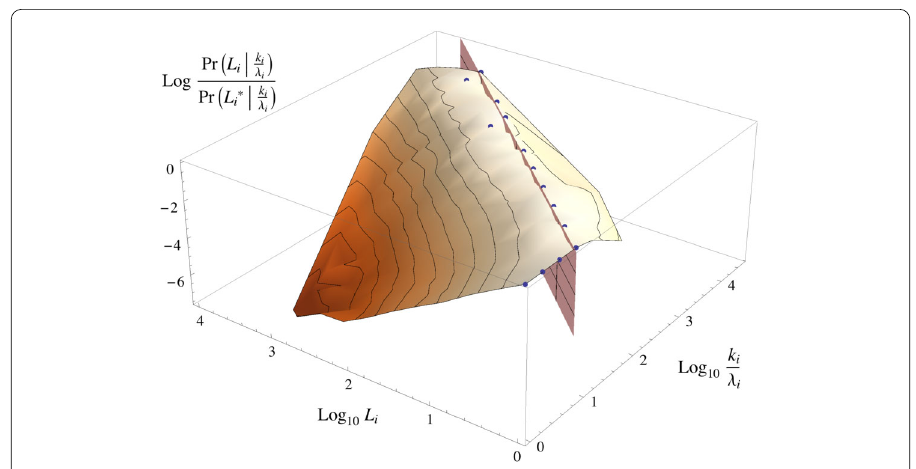
| k S ) with respect to log λ i for Figure 6 Behavior of log 10 [Pr( L i | k i / λ i )/Pr( L ∗ i / λ i )] (surface 10 L i and log 10 k i / i Finland. The data is logarithmically binned as follows: L i belongs to bin b (a non-negative integer) if L min ζ b < L i ≤ L min ζ b +1 with ζ > 1 (for this plot ζ = 2) and L min = min[ { L i } ] (smallest firm size in the data); k i / λ i is binned in the same way with ζ and ( k / λ ) min = min[ { ( k i / λ i ) } ]. Blue points represent the local maximum of S at each bin. The vertical plane P is parametrized as ( k i / λ i , C L k i / λ i , z ) where z is a free parameter. C L is chosen (cid:2) ∗ – C L ( k / λ ) b ) 2 with the first three bins excluded because the smallest firm size is 1. The large to minimize b ( L b range within which the intersection of P and S runs parallel to the maxima of S strongly supports Eq.